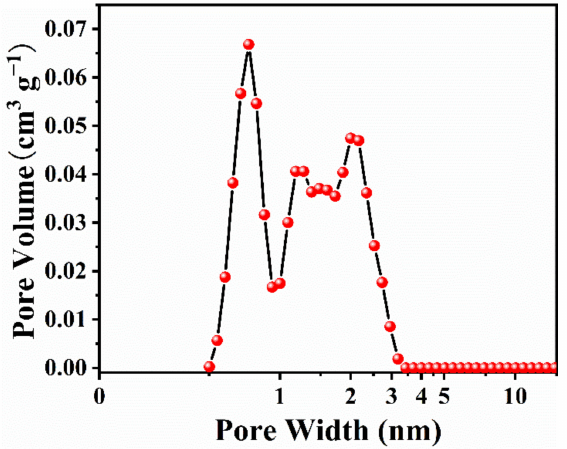
Figure 1. Pore size distribution of the activated